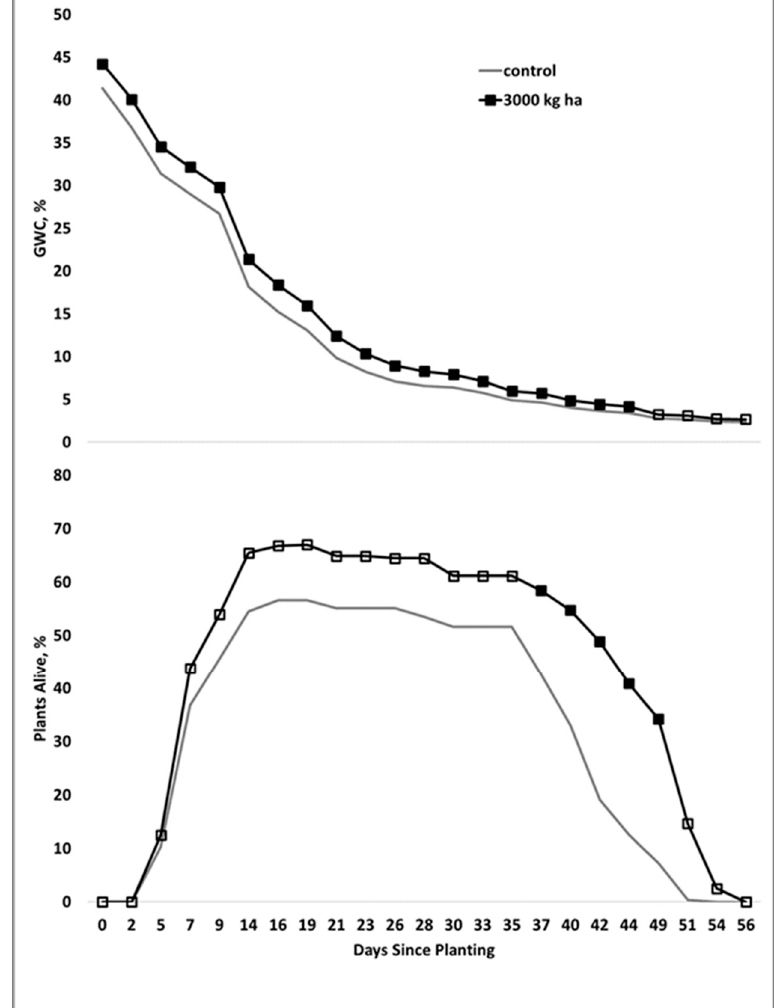
Figure 4. Increase in gravimetric water content (GWC) and viable seedlings as a function of superabsorbent polymer (SAP) application and time in a glasshouse study for bottlebrush squirreltail and Siberian wheatgrass. Data were averaged across all seeding rates of 2, 4, 8, and 16 kg ha − 1 . The SAP rate of 3000 kg ha − 1 was placed in a band at a depth of 8 cm directly below the seed. Following SAP treatment, the soil was saturated once and then dried down naturally over the time of the study. For the treated plots, with square markers, the solid (filled in) markers indicate highly significant ( p < 0.0001) differences compared to the control for that day, and open (not filled in) markers are not significant.